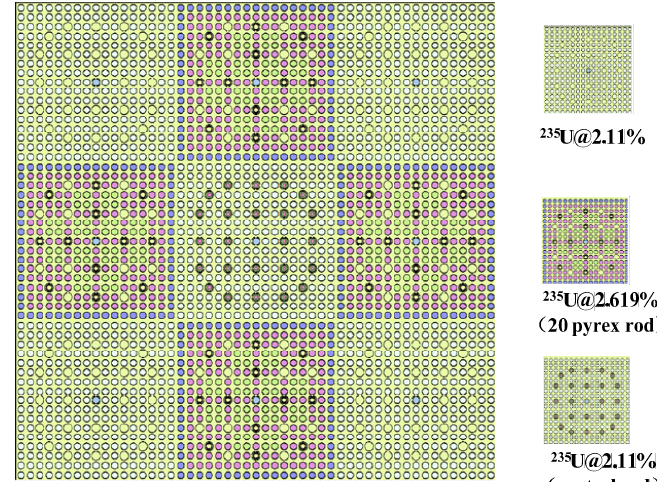
Figure 4. Problem 4-2D lattice layouts.